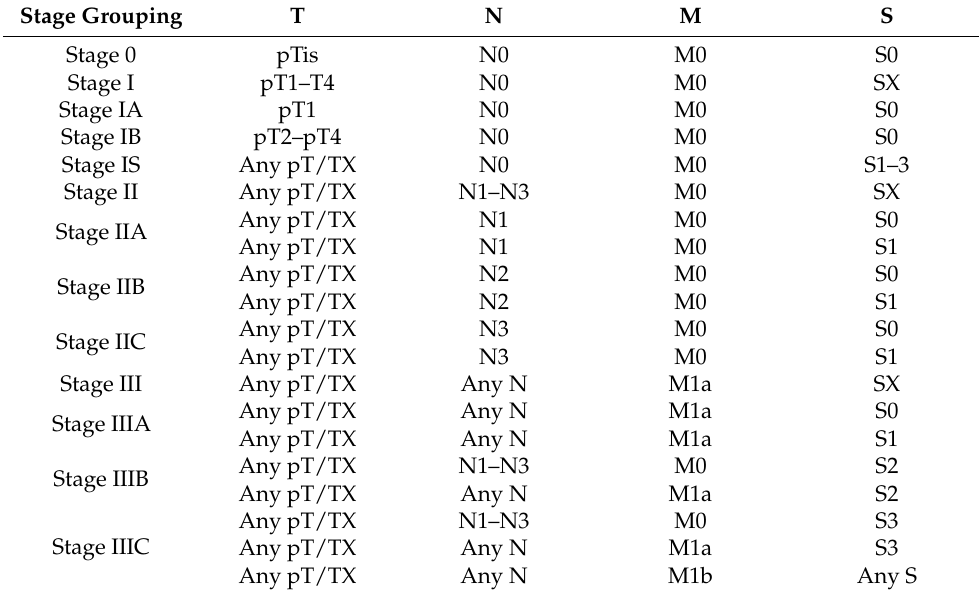
Table 2. Prognostic groups for testicular cancer [13].